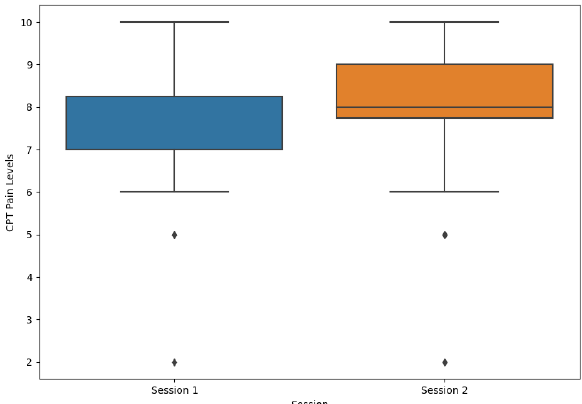
Figure 7. Pain levels reported by participants before the end of the CPT for both